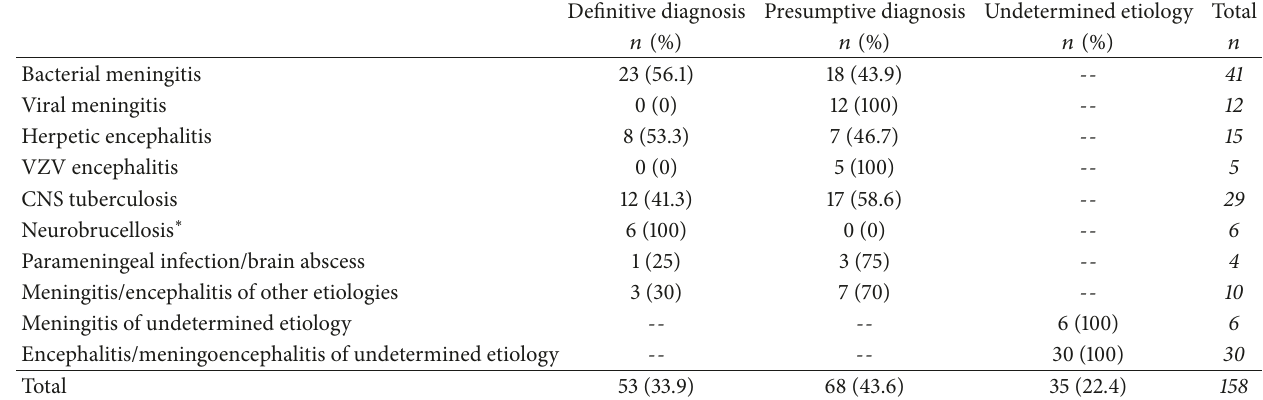
Table 1: Frequency distribution and etiological spectrum of patients with CNS infection.